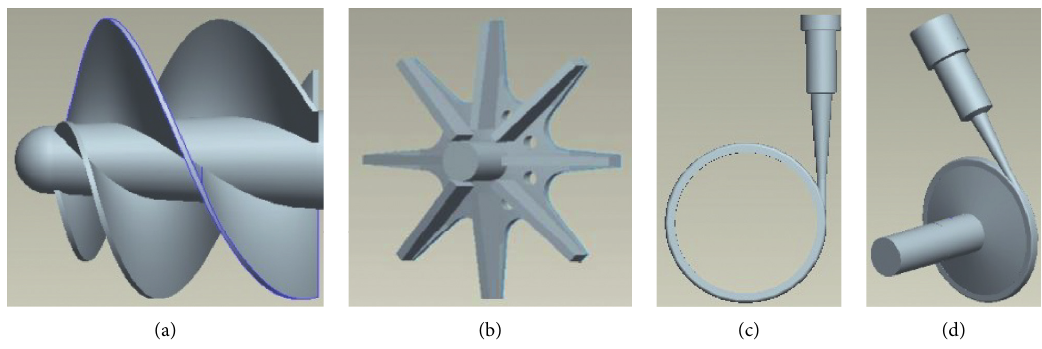
Figure 1: Internal flow field model of the high-speed partial emission